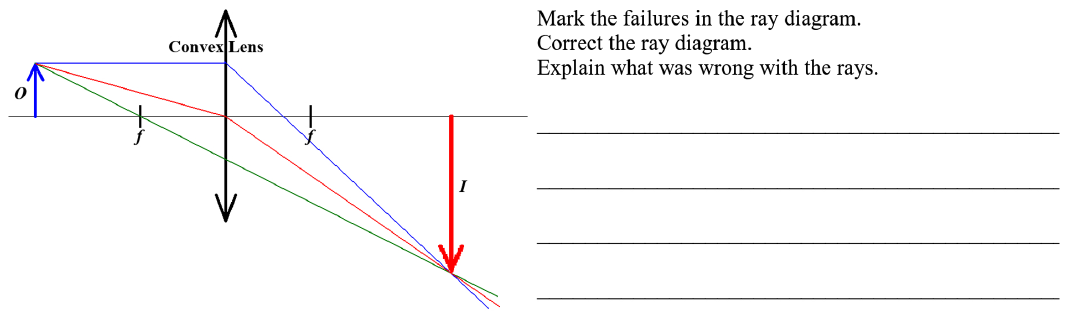
FIG. 3. RAT for fostering students ’ ability to check the scientific correctness of a representation (correction